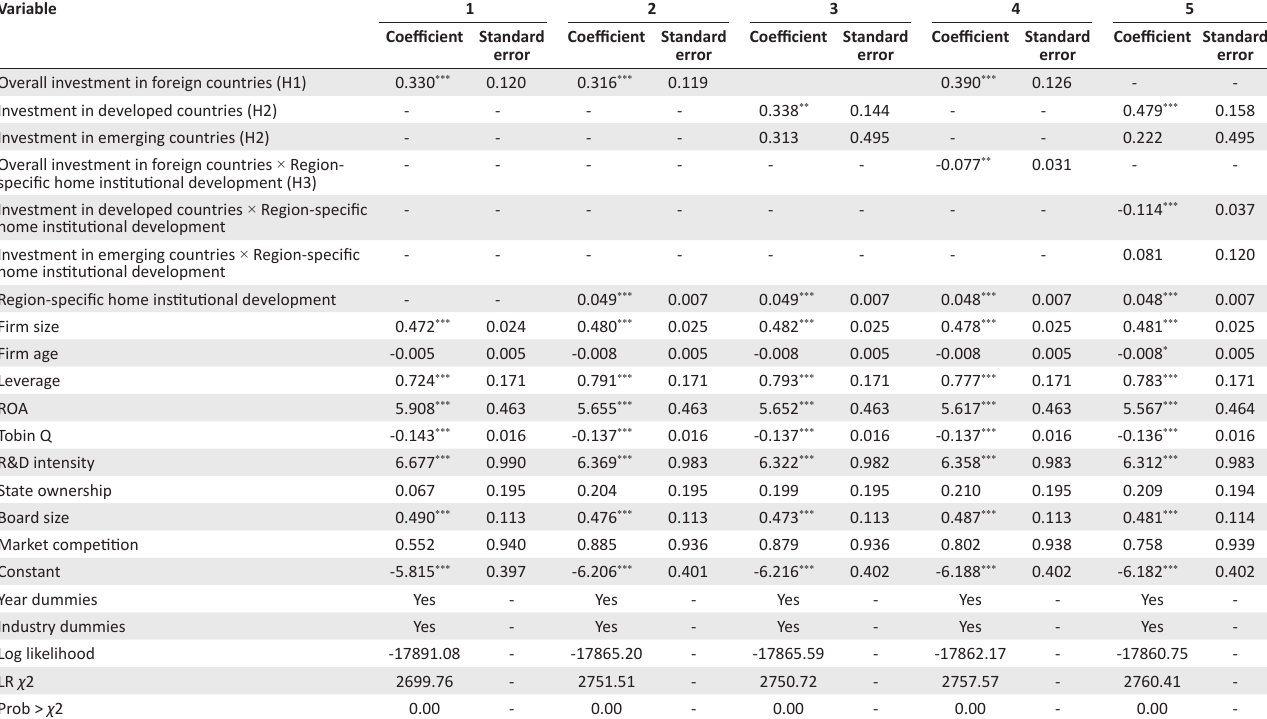
TABLE 2: The analysis of outward foreign direct investment and green innovation ( N = 14 129).